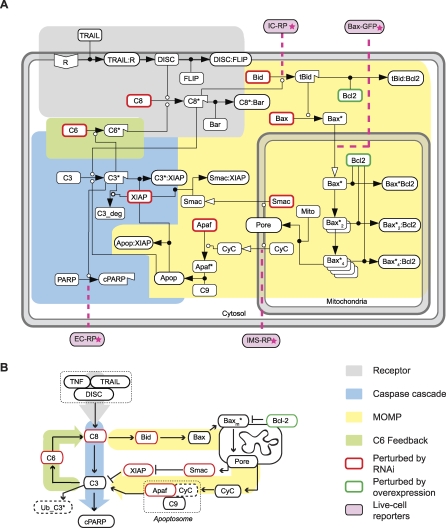
Process Diagram of the Death Receptor Network Modeled in This Study(A) The convention of Kitano et al. [94] is followed. The major features of the network are highlighted by color: gray, receptor module; blue, direct caspase cascade; green, positive feedback loop; yellow, mitochondrial feed-forward loop.(B) A condensed alternate representation of the network.